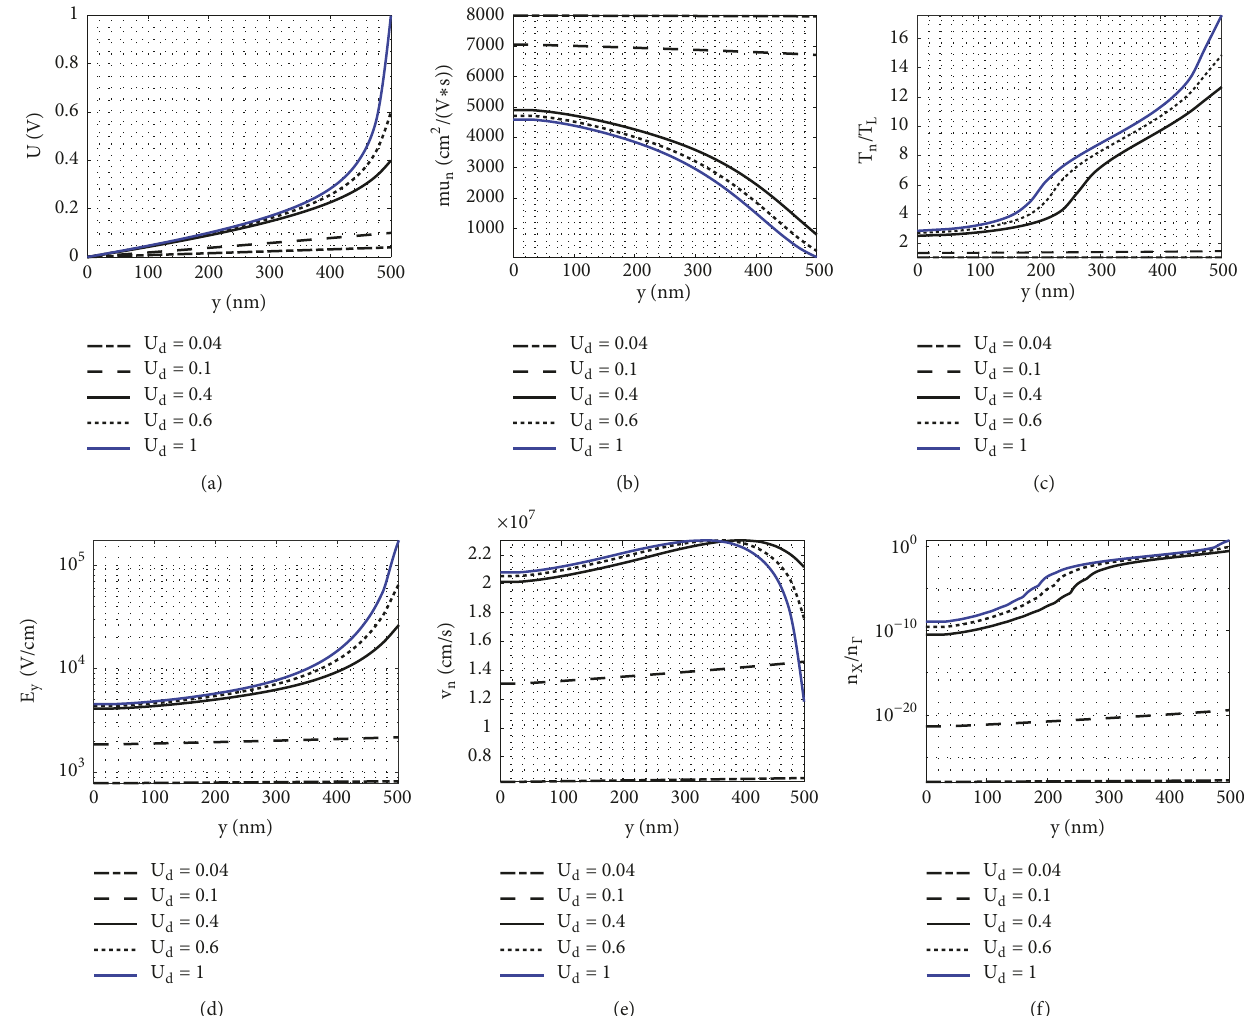
Figure 2: Numerically calculated spatial distributions of the potential (a), the electron mobility (b), the electron temperature (c), the electrical field (d), the electron drift velocity (e) 𝑤 and X- and Γ -valley population ratio (f) within the channel with the different value of the drain voltage 𝑈 𝐿 𝑈 𝑑 . The gate length and gate voltage are 𝑔 = 500 nm and 𝑔 = 0.5 V, respectively.